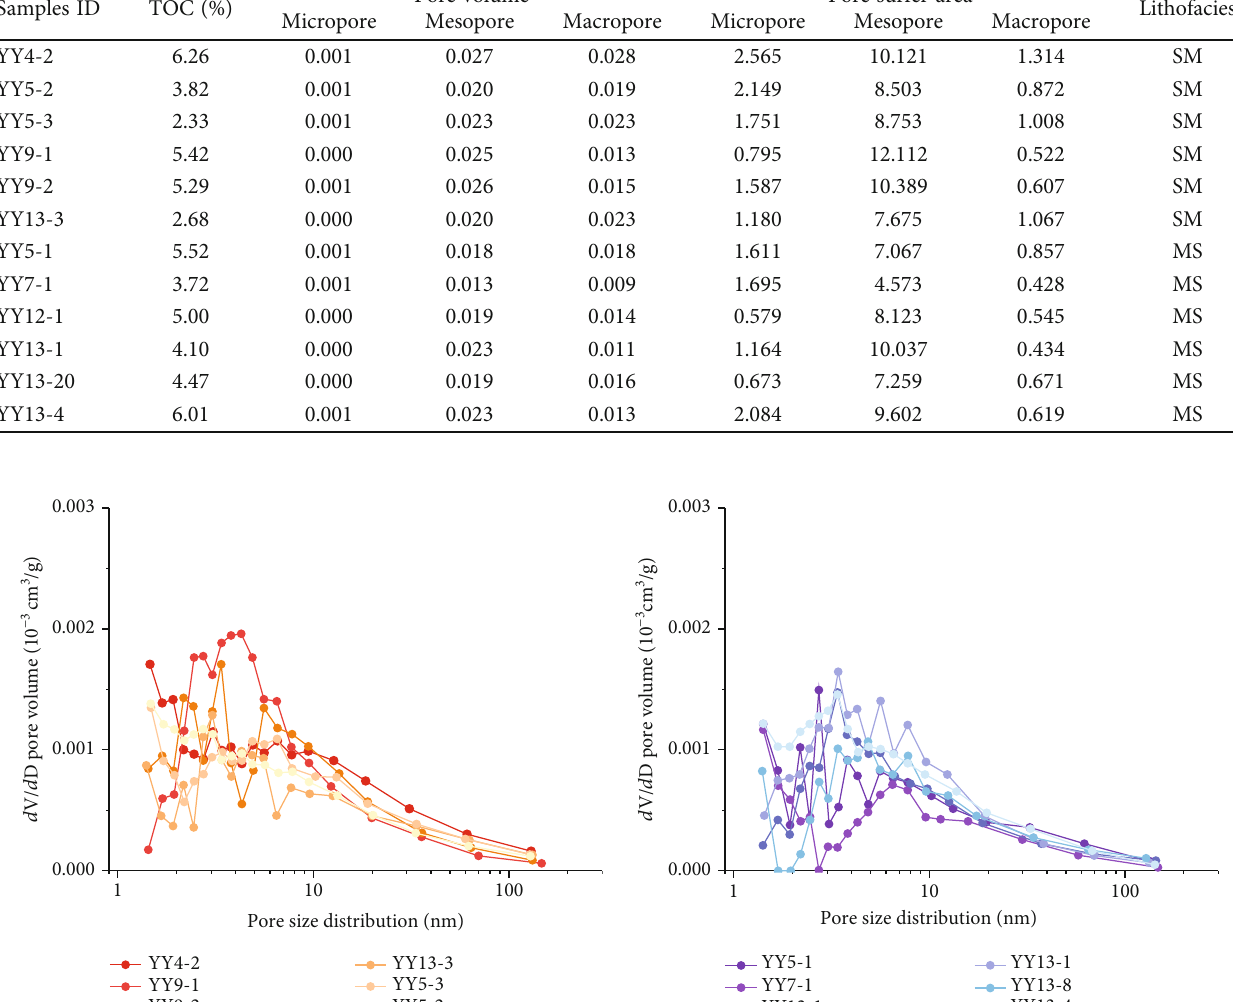
Table 3: Pore structure parameters of MS and SM lithofacies from low-pressure N Samples ID TOC